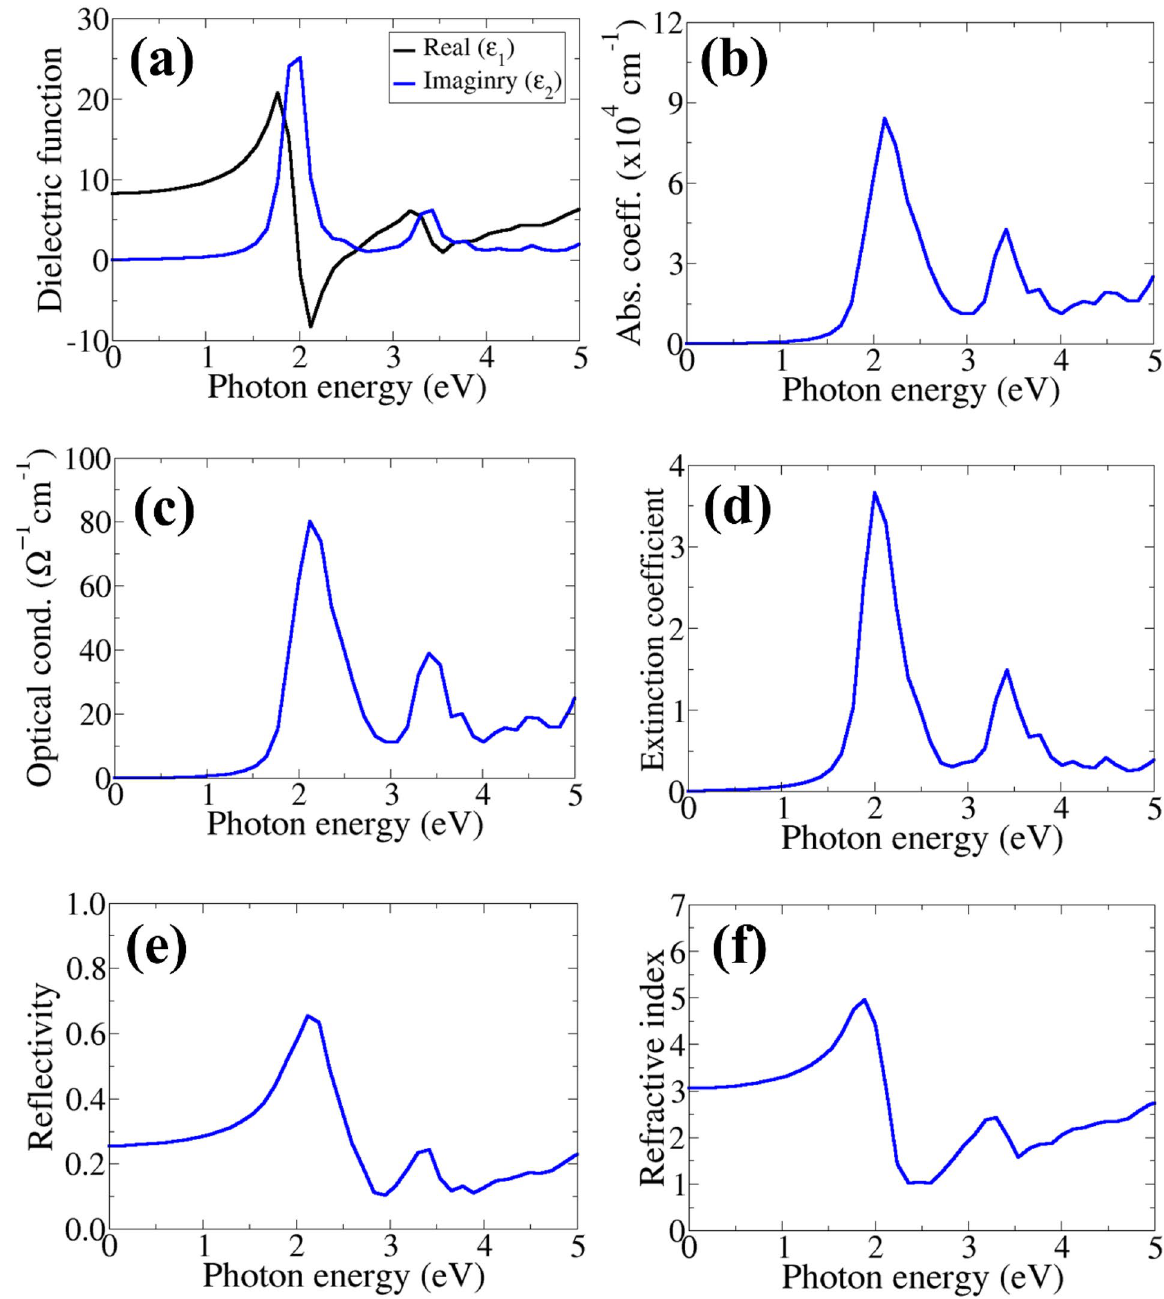
Figure 4. Calculated ( a ) real and imaginary part of the dielectric function, ( b ) absorption, ( c ) optical conductivity, ( d ) extinction coefficient, ( e ) reflectivity, and ( f ) refractive index of Cu 2 SrSnS 4 for CIGS 66 , CdTe 67 , and CZTS 68,69 absorbers. The slightly larger CBO at the CSTS/CdS interface compared to that of the CZTS/CdS interface (0.21 eV) 68,69 , indicates that interface and band offset engineering is required to lower the barrier height at the CSTS/CdS interface and promote efficient charge carrier separation. As was demonstrated to improve the performance of SnS solar cells 70,71 , a contact metal with lower work function may be needed at the opposite sides of the junction for CSTS.